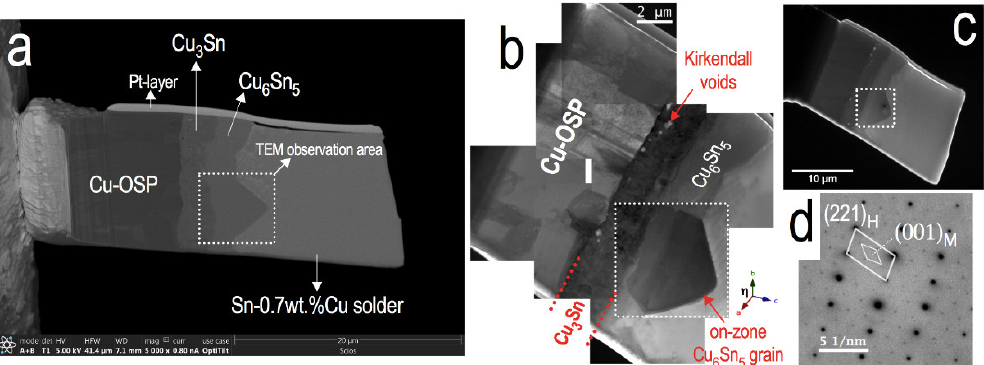
Figure 1. FIB lamella sample. ( a ) Backscattered SEM image; ( b ) high and ( c ) low magnification bright-field plasmon-filtered TEM images; ( d ) SADP of the fresh selected Cu 6 Sn 5 grain at room temperature before the in-situ heating experiment.